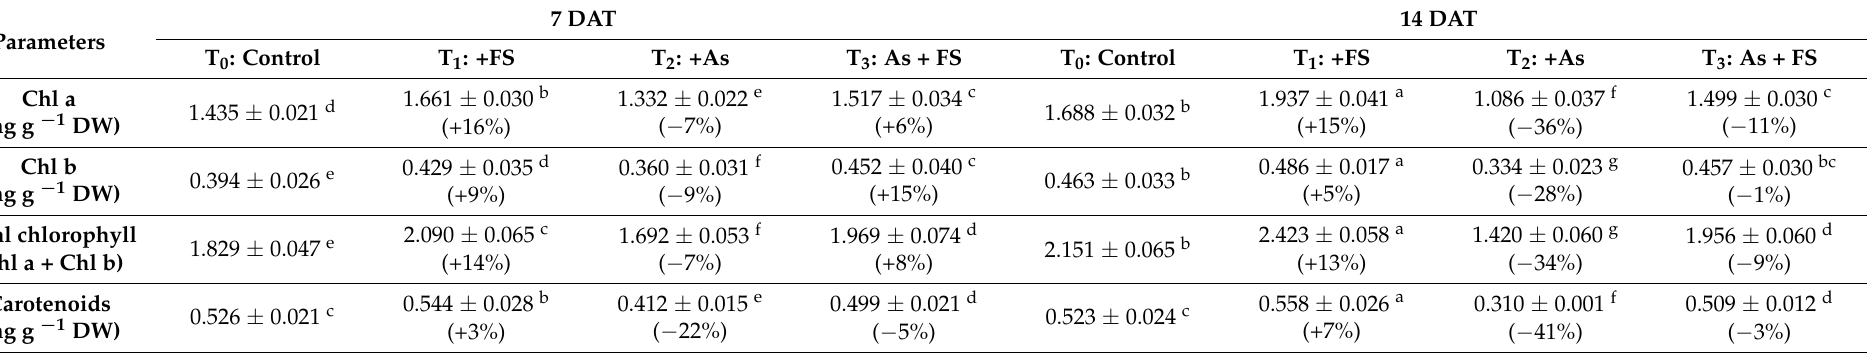
Table 3. Impact of iron sulfate (T 1 : +FeSO 4 ), arsenic stress (T 2 : +As) and iron sulfate supplementation during As stress (T 3 : As + FeSO 4 ) on contents of chlorophyll